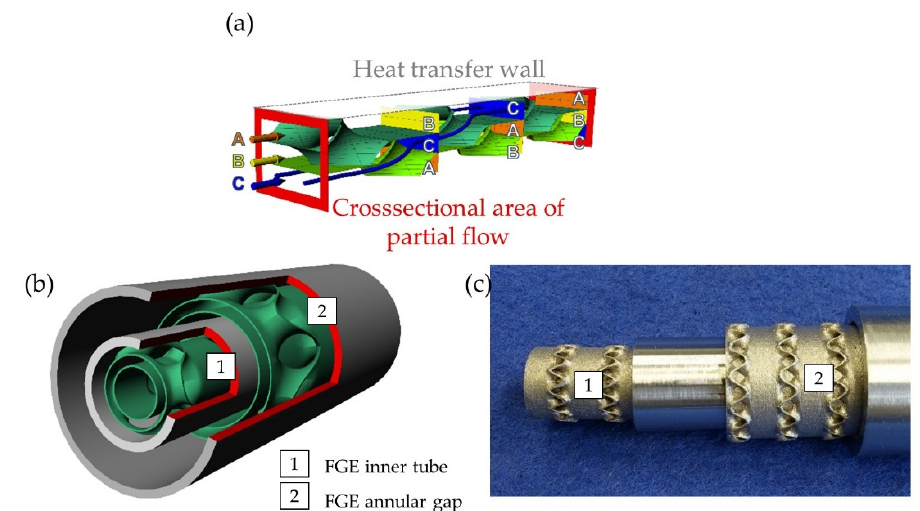
Figure 2. ( a ) Partial flow paths in the FGE, adapted from [18]. ( b ) Double-pipe configuration with FGEs in both the internal tube and the annular gap, adapted from [18]. ( c ) Picture of the double-pipe configuration fitted with FGEs.